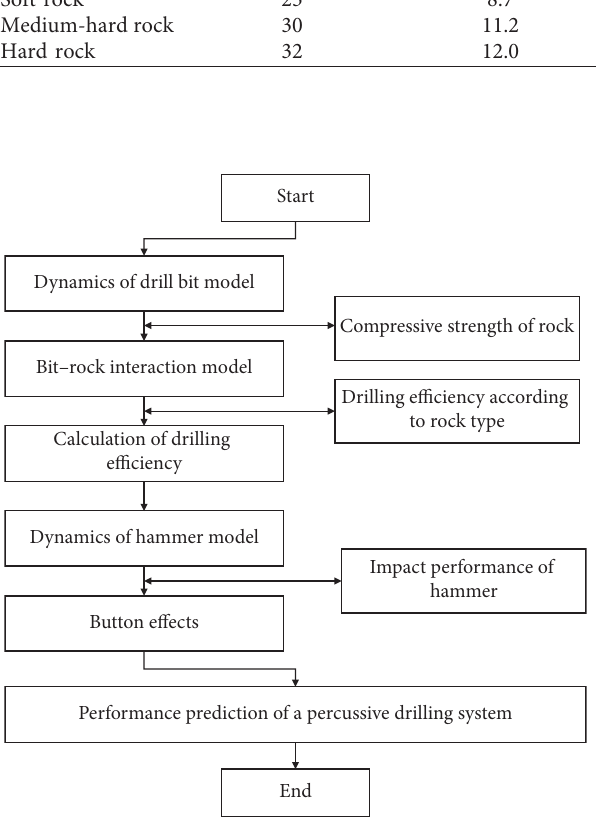
Figure 5: Block diagram for predicting the performance of a DTH